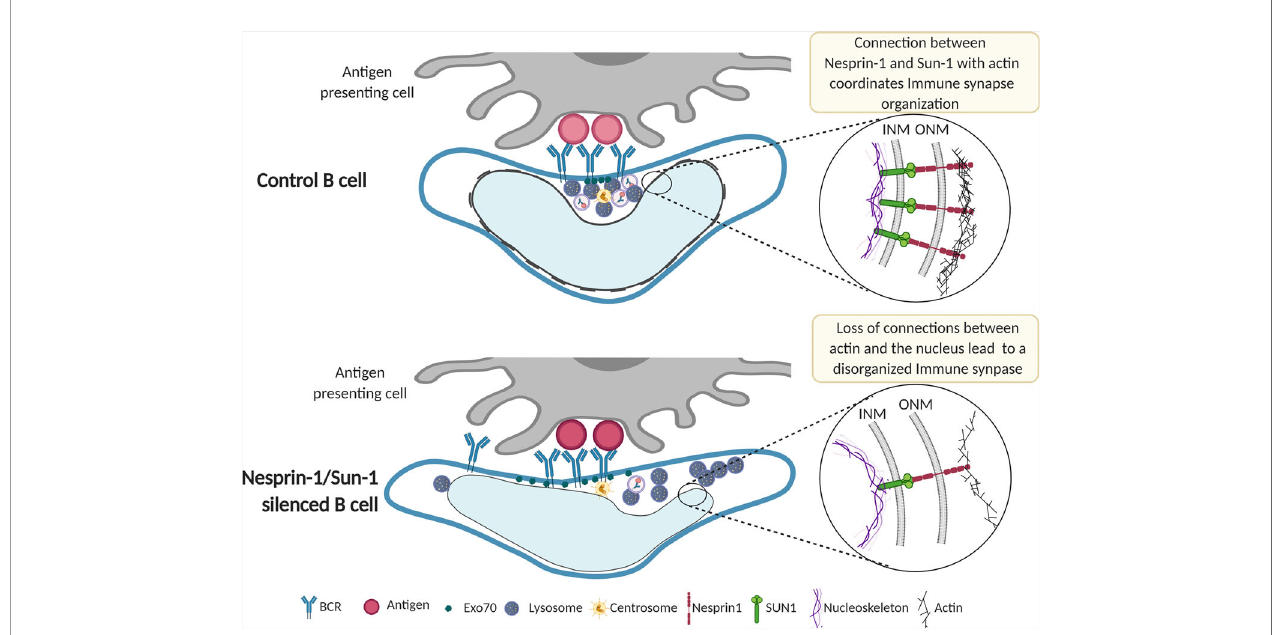
FIGURE 6 | Model of immune synapse organization controlled by nuclear envelope proteins Nesprin-1 and Sun-1. Upon activation, the immune synapse formed by a B cell and antigen-presenting cell is well organized. The MTOC, Exo70, and lysosomes are recruited to the center of the immune synapse, where antigen-BCR complexes are clustered and internalized. This region is formed by the positioning of the nuclear groove, which orchestrates cytoskeleton remodeling and membrane traf fi cking. In Nesprin-1- and Sun-1-silenced B cells, connections between actin and the nucleus are lost; the nuclear groove fails to orient towards the antigen contact site, leading to a disorganized immune synapse. This disorganized synapse is characterized by diminished BCR clustering at the center of the synapse and defective Exo70 recruitment, impairing local tethering of lysosomes required to ef fi ciently extract and process immobilized antigens. Further studies are required to elucidate how physical changes in the shape of the nucleus impact immune synapse